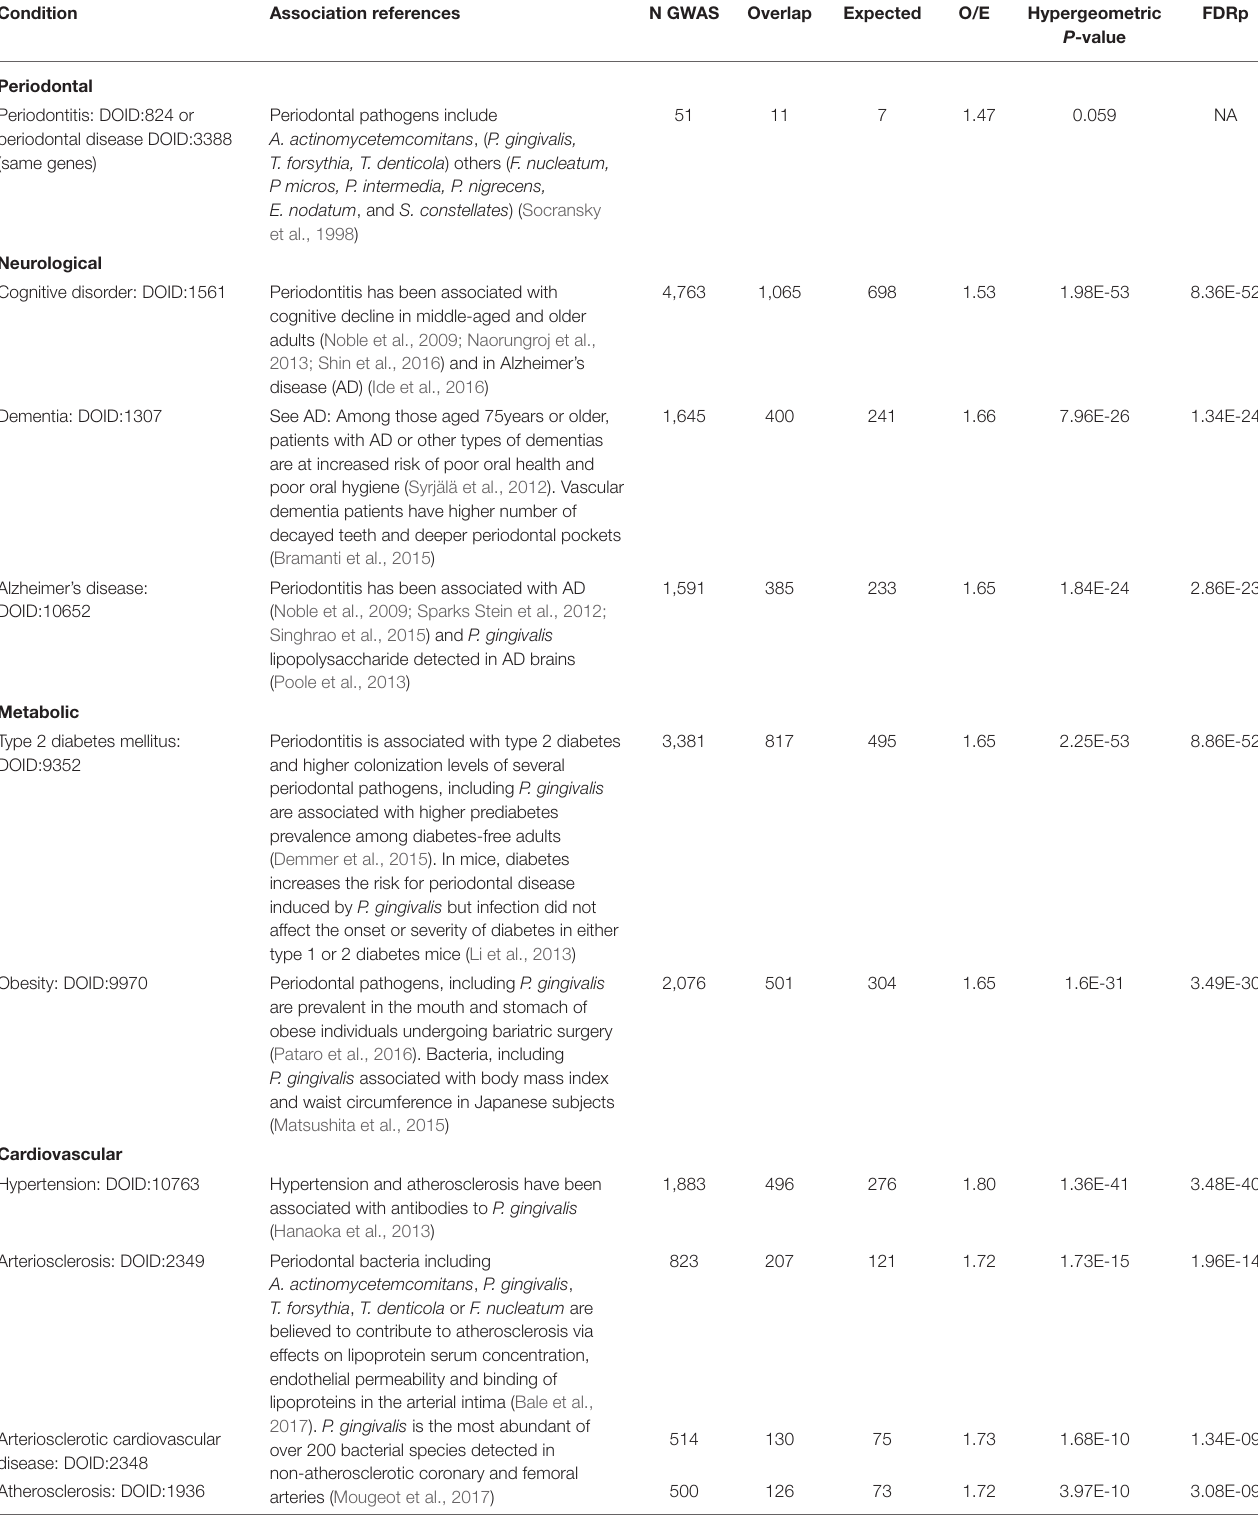
TABLE 1 | The overlaps between the host genes of the P. gingivalis interactome with genes associated with diverse diseases from the GWASdb (top unshaded region) or the NCBI-EBI (bottom shaded region) databases. Condition Association references N GWAS Overlap Expected O/E Hypergeometric